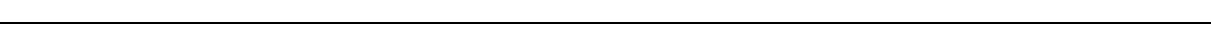
NKD1 coimmunoprecipitated with endogenous TNKS (Fig. 5f). Together these data indicate NKD1 as a target of tankyrase.